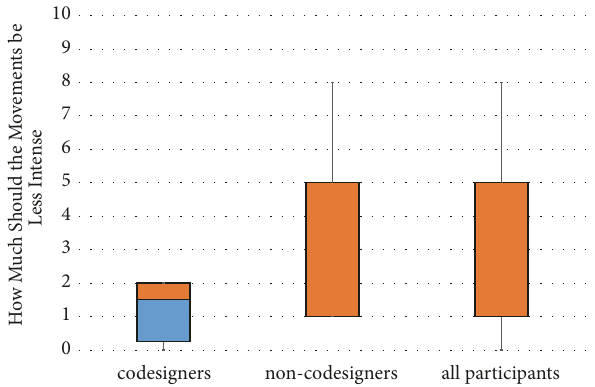
Figure 22: Answers from topic 15 of Table 9: this topic measures how much testers would prefer the movements in the game to be less